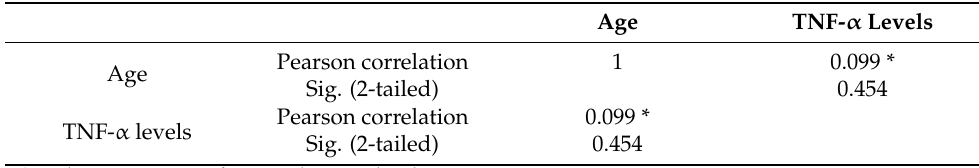
Figure 1. ( A ) Photomicrograph of non-snuff dipper buccal cell showing the nucleus (black arrow) and cytoplasm (red arrow) at 1000X and ( B ) photomicrograph of snuff-dipper buccal cell showing multiple micronuclei (black arrows), nucleus of buccal cells (red arrow), and cytoplasm (blue arrow) (Giemsa stain, 1000X). Table 3. Correlation between age and TNF- α levels.